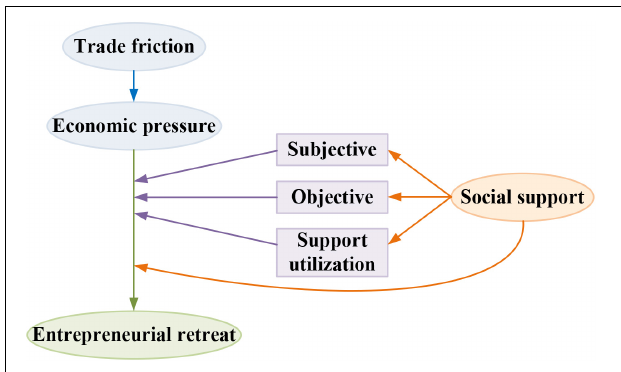
FIGURE 1 | Model of effect of the entrepreneur’s thought of